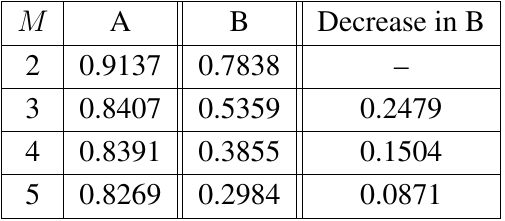
Table 5. Factors calculated from nonlinear regression.